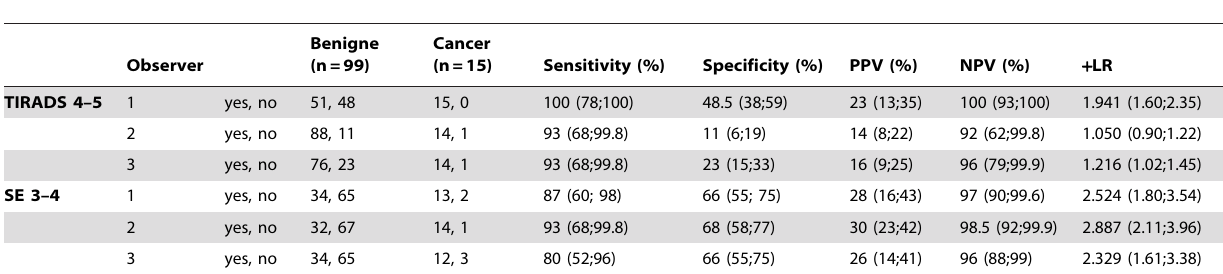
Table 3. Diagnostic value of TIRADS and SE for the diagnosis of malignant thyroid nodules.